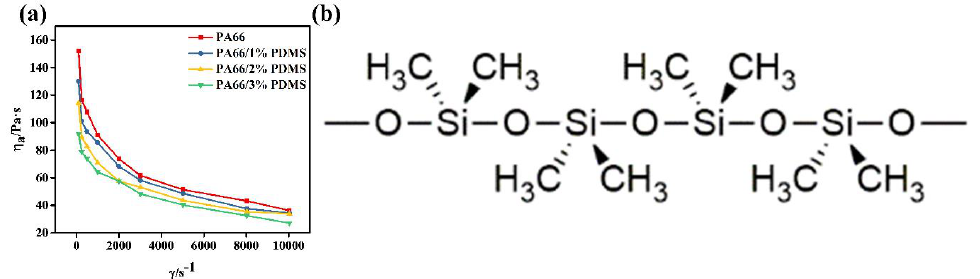
Figure 1. The flow curves of PA66 and PA66/PDMS melts ( a ), and chemical conformation of PDMS ( b ).